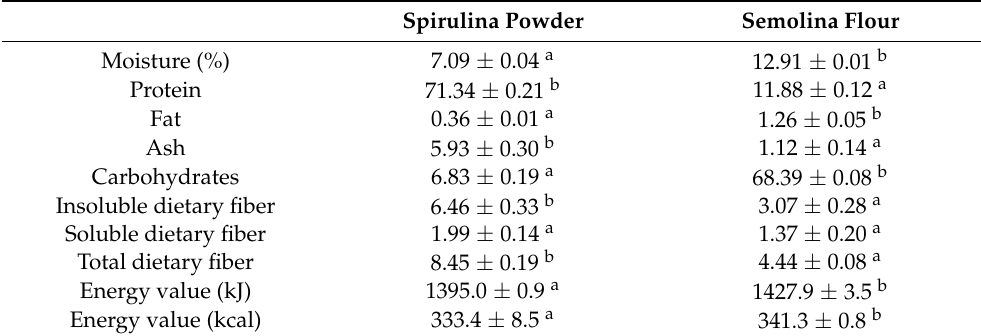
Table 1. Proximate macronutrients content (g/100 g of dry matter) and energy value of the spirulina powder and semolina